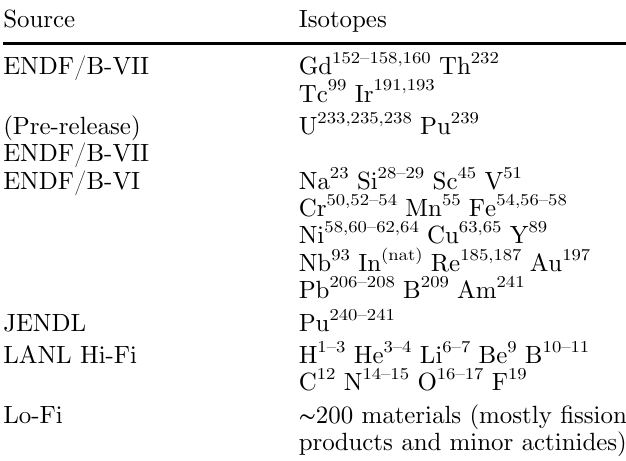
Table 3. Sources of covariance data in the SCALE 6.1.3 covariance